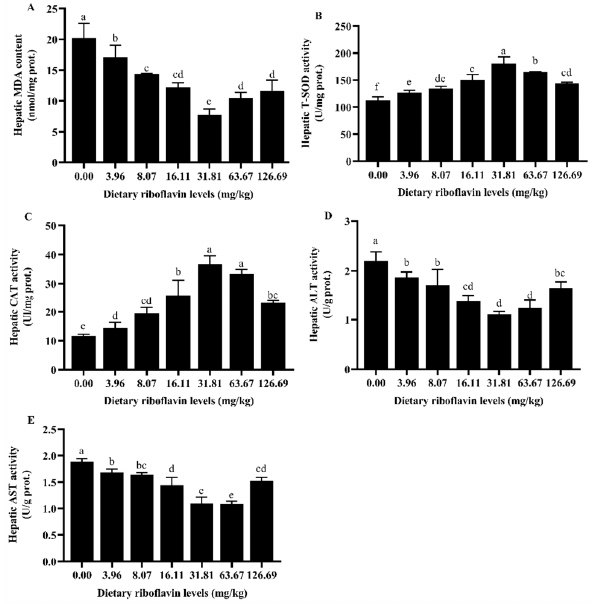
Figure 2. Effect of dietary riboflavin levels on hepatic MDA, T-SOD, CAT, ALT and AST activities of coho salmon ( Oncorhynchus kisutch ) post-smolts for 12 weeks. ( A ) MDA; ( B ) T-SOD; ( C ) CAT; ( D ) ALT; ( E ) AST. Values are expressed as mean ± SD of three replicate groups. Means with different superscript letters are significantly different ( p < 0.05). Abbreviations: MDA, malondialdehyde; T-SOD, total superoxide dismutase; CAT, catalase; ALT, alanine aminotransferase; AST, aspartate aminotransferase. 3.4. MDA, Triglyceride, Total Cholesterol, ALT, AST Activities in Serum The activities of MDA, total cholesterol and AST in serum of coho salmon decreased significantly with the increase of dietary riboflavin level up to 31.81 mg/kg ( p < 0.05), which was significantly lower than those of groups of 63.67 and 126.69 mg/kg (Figure 3A,C and E). The serum triglyceride content decreased significantly with the increase in dietary riboflavin level up to 63.67 mg/kg, which did not differ significantly from that of the 31.81 mg/kg group but was significantly lower than that of the 126.69 mg/kg group (Figure 3B). The serum ALT content decreased significantly with the increase of dietary riboflavin level up to 31.81 mg/kg and then leveled off (Figure 3D).